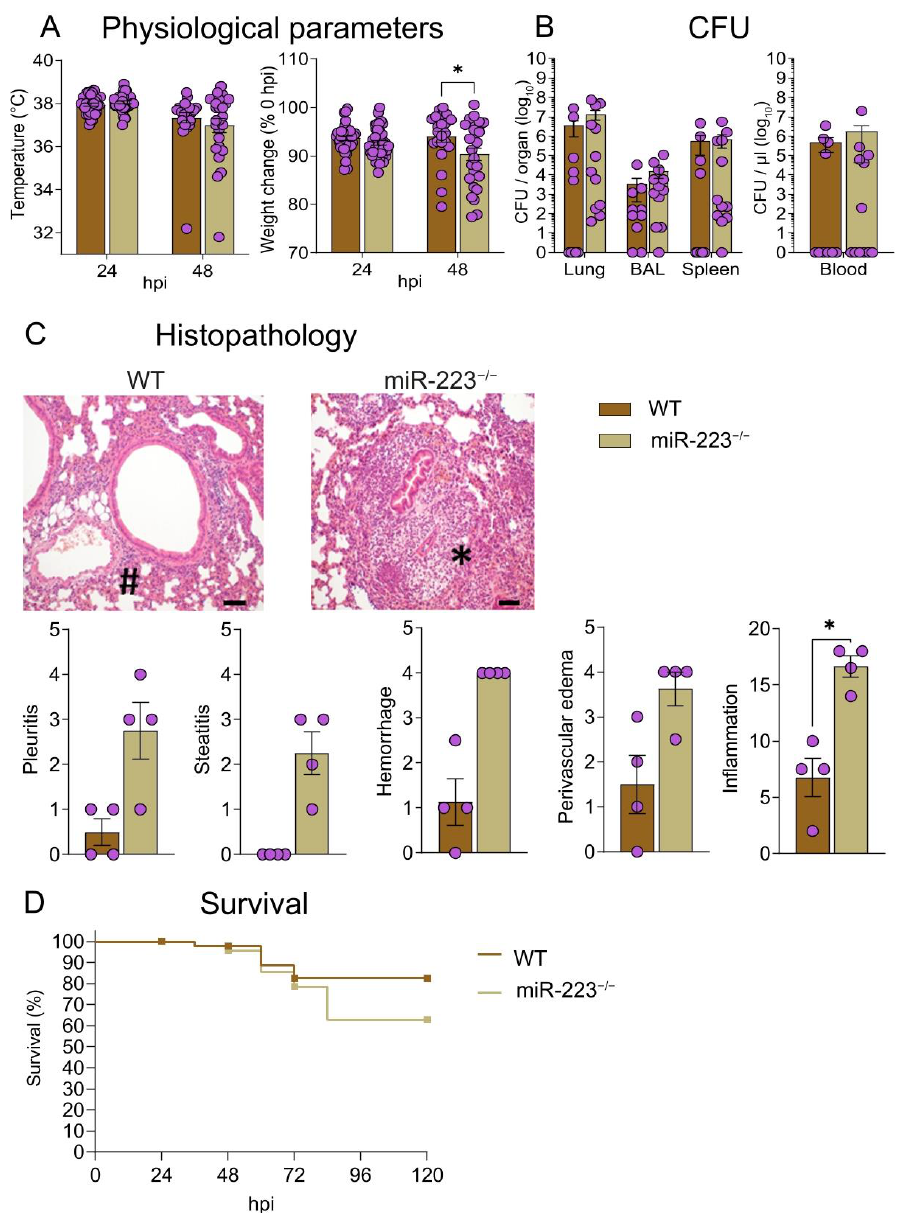
Figure 2. miR-223 − / − mice exhibit aggravated lung inflammation 48 hpi S.pn. ST2. ( A ) Physiological parameters, including changes in body temperature and body weight post- S.pn . infection in WT and miR-223 − / − mice. ( B ) Bacterial burden recorded in lungs, BAL, spleen and blood in WT and miR-223 − / − mice 48 hpi ( n = 10–12). ( C ) Histopathological analyses of murine lungs 48 hpi. H&E staining indicates predominant neutrophilic and lymphocytic cellular infiltrates in lungs of miR-223 − / − and WT mice, respectively. Pictures are representative of overall inflammation in WT and miR-223 − / − mice. * denotes predominantly neutrophilic infiltrates coupled to pronounced edema, whilst # denotes perivascular lymphocytic cuff formation coupled to marginal edema. Pleuritis, steatitis, perivascular edema and hemorrhage scores collectively represent the overall inflammation score exhibited in the lungs of WT and miR-223 − / − mice 48 hpi ( n = 4). Scale bar indicates 100 µ m. ( D ) Survival curves of S.pn. ST2-infected WT and miR-223 − / − mice over the duration of 120 hpi. ( A ) 2-way ANOVA/Šid á k’s multiple comparisons test, * p < 0.05. ( C ) Mann-Whitney U test was performed to analyze statistical significance in the overall inflammation score; * p < 0.05. Data in ( A – C ) display individual and mean values, while data in ( D ) displays censored subjects only. hpi: hours post-infection, CFU: colony-forming unit, BAL: bronchoalveolar lavage.